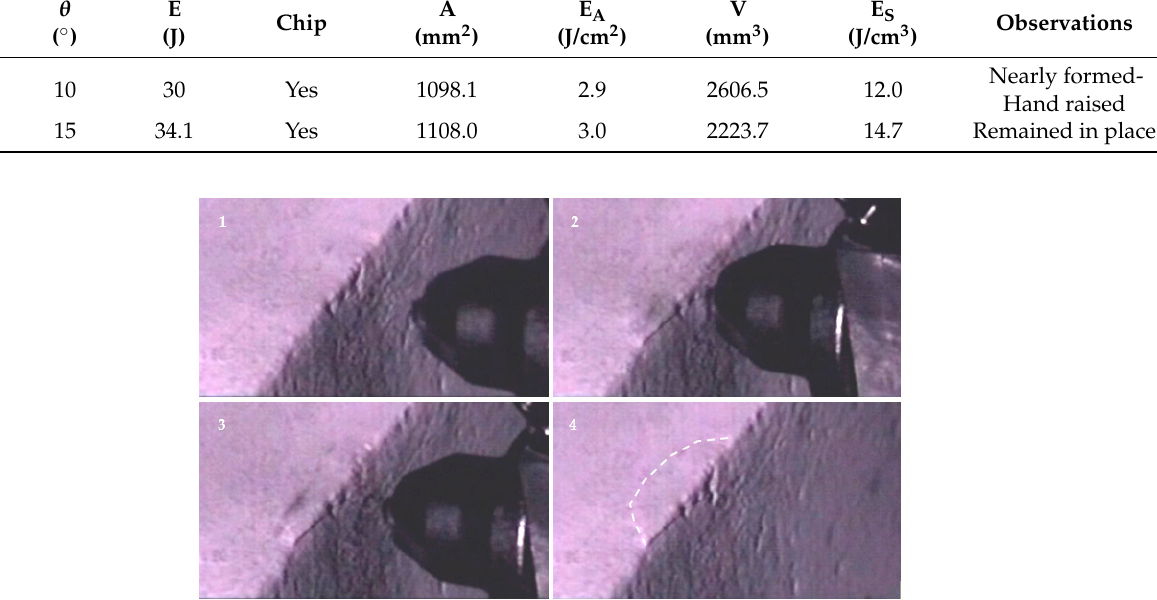
Table 5. Summary of optimum energy calculation tests. (The precision of the measures is of 0.5 ° for θ , and 5 mm for the scanner).